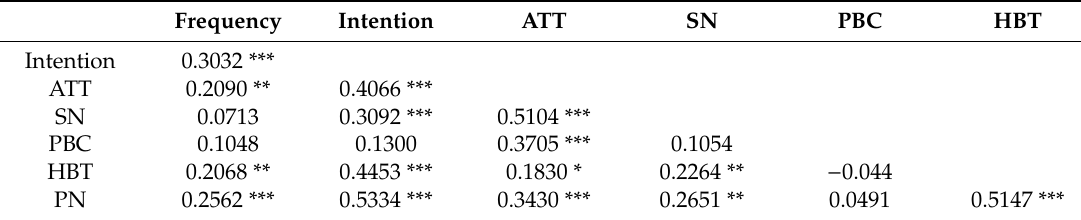
Table A3. Correlation between TPB constructs, perceived need, and habit for egg consumption ( n = 92). Frequency